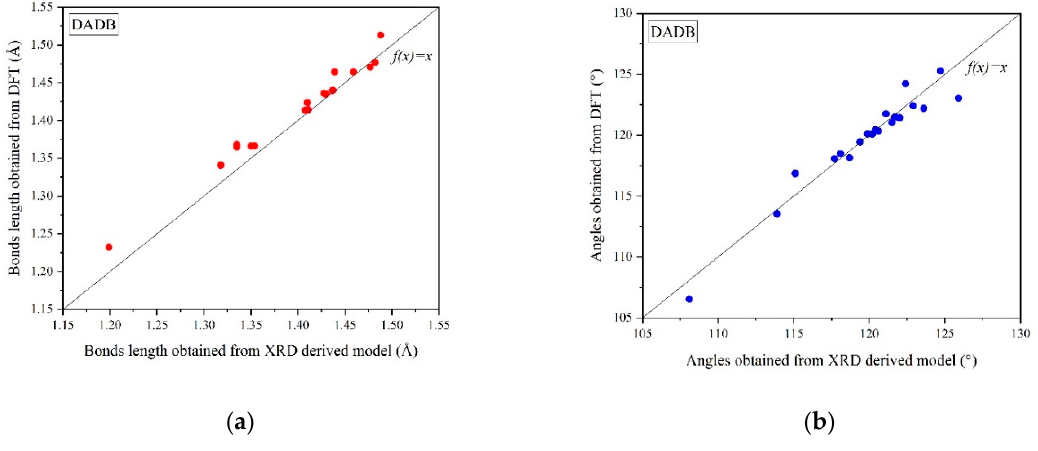
Figure 9. Comparison between the ( a ) bond lengths and ( b ) angles obtained using DFT method (M06-2X) and experimental result for DADB molecule.